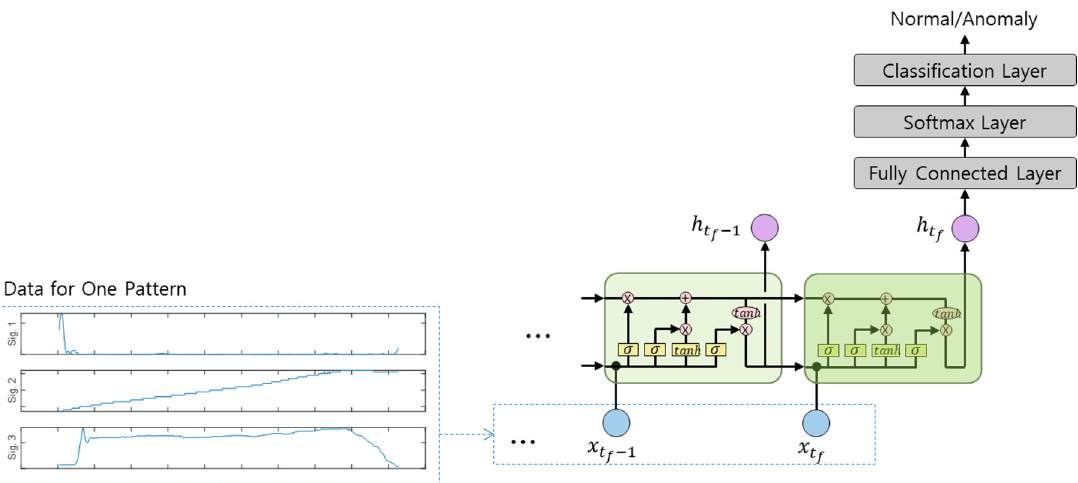
Figure 8. LSTM-based anomaly detection model training architecture.